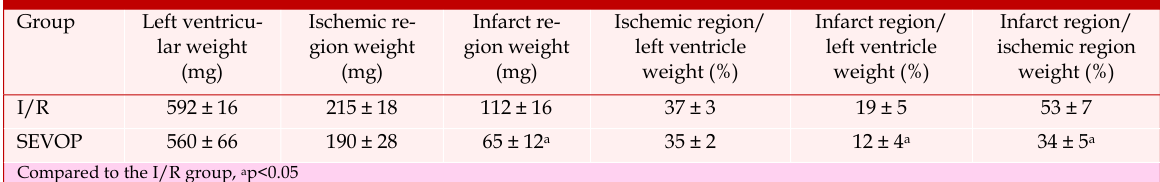
Comparison of myocardial infarction areas in rats between the I/R and SEVOP groups ( n ＝ 6, x ± s )